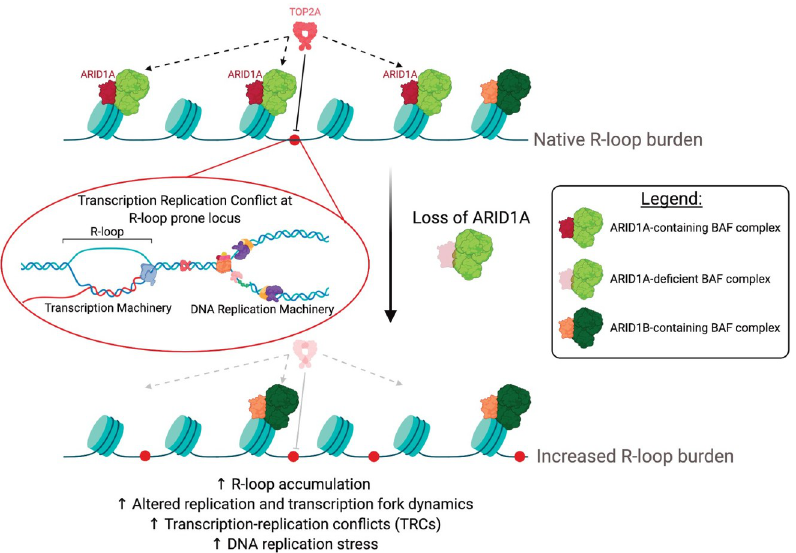
Fig 5. Model. Under normal conditions, ARID1A-containing BAF complexes recruit TOP2A to chromatin where it can prevent the formation of TRC-inducing R-loops. Upon loss of ARID1A, TOP2A is not appropriately recruited to chromatin, resulting in increased R-loop burden, altered replication and transcription dynamics, increased incidence of TRCs and DNA replication stress. Model figure was created with BioRender.com.